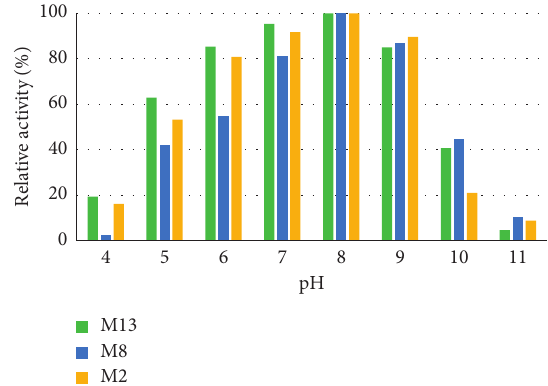
Figure 13: Effect of pH on amylase activity of the selected isolates.